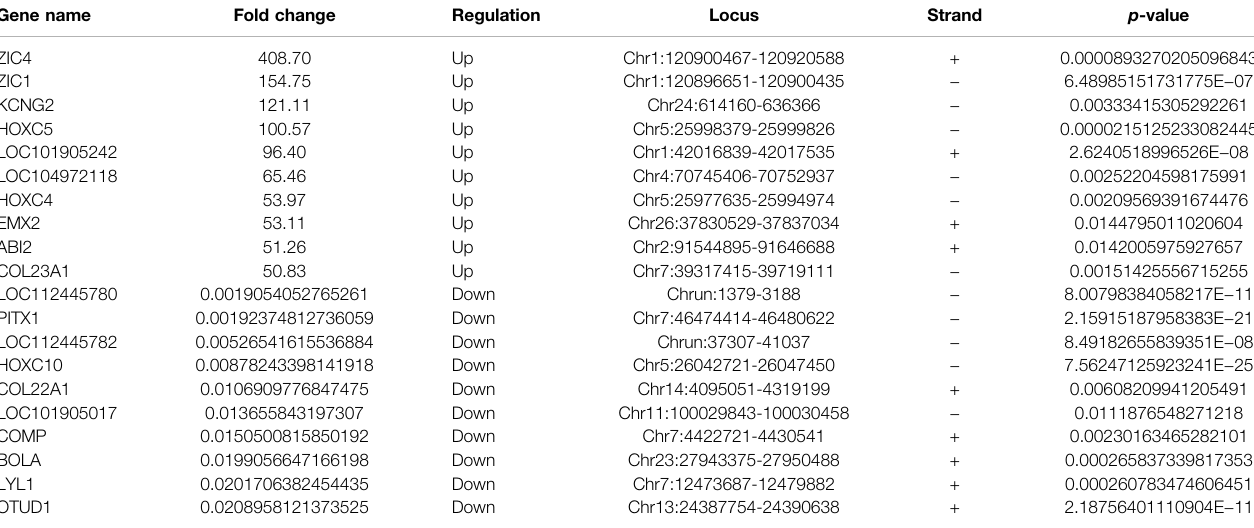
TABLE 5 | The top 20 differentially expressed